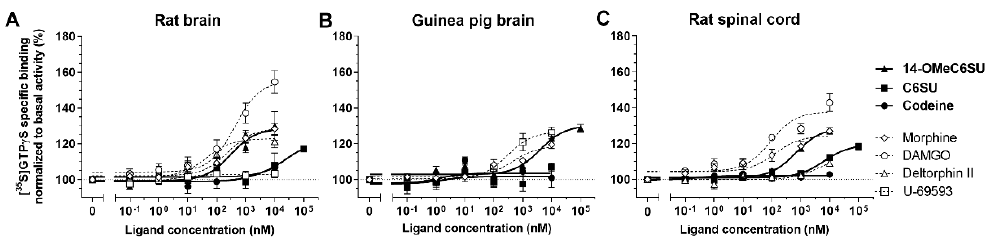
Figure 3. 14-methoxycodeine-6- O -sulfate (14-OMeC6SU) compared to codeine-6- O -sulfate (C6SU) and codeine in [ 35 S]GTP γ S binding assays performed in rat ( A ) and guinea pig ( B ) brain and rat spinal cord ( C ) membrane homogenates. For comparison standard µ -, δ - and κ -opioid receptor selective agonists, DAMGO, deltorphin II (Delt II) and U-69593, respectively are also presented. Figures represent the specific binding of [ 35 S]GTP γ S in percentage (means ± S.E.M.) in the presence of increasing concentrations (0.1 nM–100 µ M) of the indicated ligands. “Total” on the x-axis indicates the basal activity of the monitored G-protein (defined as 100%, its level is presented as a dotted line), which is measured in the absence of the compounds and also represents the total specific binding of [ 35 S]GTP γ S. E max and EC 50 ± S.E.M. values are presented in Table 2. Table 3. Examining the opioid receptor mediation in G-protein activity ([ 35 S]GTPγS specific binding normalized to basal activity) of 14-OMeC6SU in the presence or absence of 10 µM naloxone in [ 35 S]GTP S binding assays performed in rat and guinea pig brain membrane homogenates. 14- OMeC6SU was added in 10 and 100 µM in rat and guinea pig brain membranes, respectively.